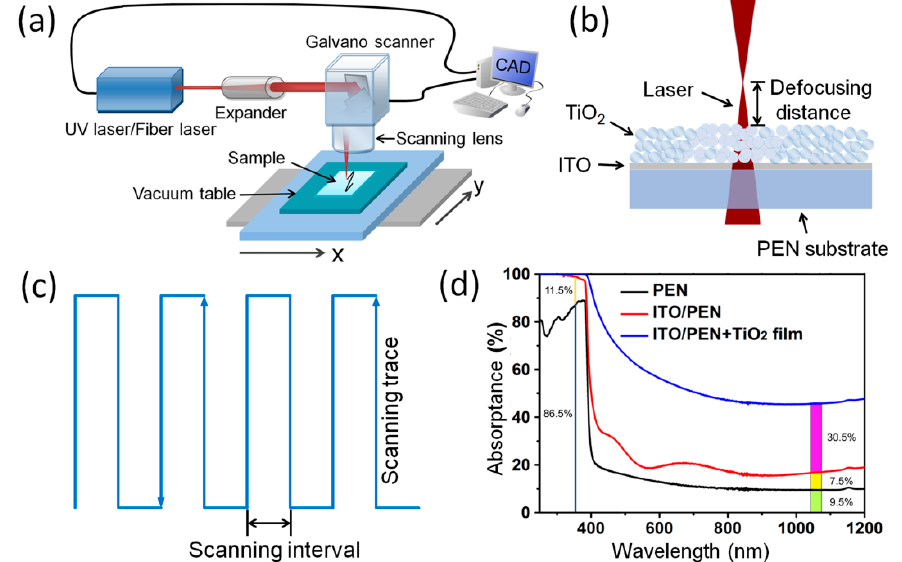
Figure 1. ( a ) Schematic device configuration and ( b ) sintering process, ( c ) scanning trace of the laser sintering, and ( d ) spectral absorption of different films. ITO: indium tin oxide; PEN: polyethylene naphthalate.